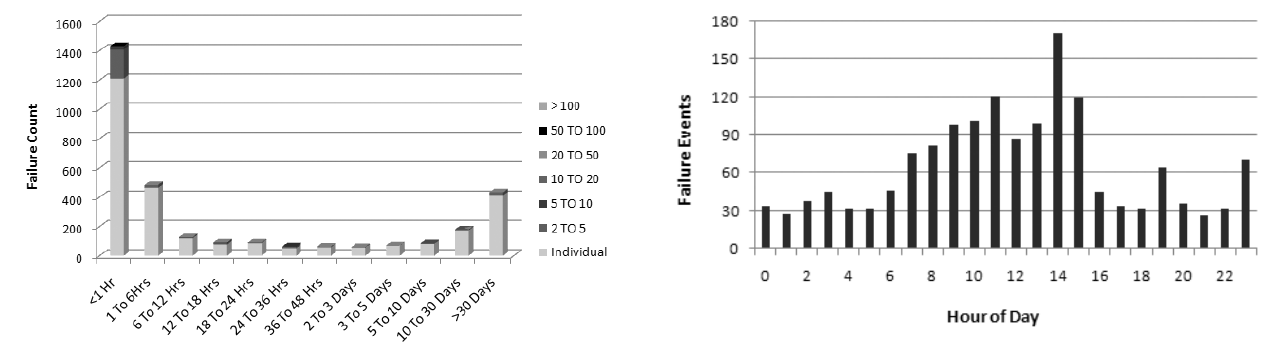
Figure 6. Missing data events by duration and event size.